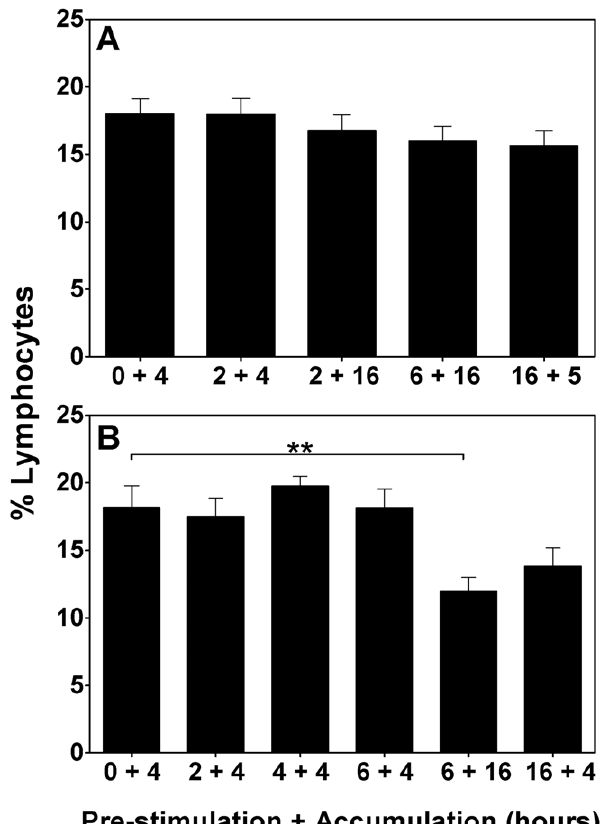
Figure 4. The effect of different culture schedules on the viability of CD4 T cells. Mouse splenocytes 6 weeks following a BCG immunization (A) and PBMC from cattle naturally infected with M. bovis (B) were isolated, stimulated with protein cocktail or PPD-B, respec- tively, stained by intracellular cytokine staining (ICS) and interrogated by flow cytometry. Graphs represent the percentage of live CD4 + lymphocytes detected in the analysis, as determined by the inclusion of a LIVE/DEAD fixable Violet dead cell stain. Data are representative of one of three independent experiments (n=6). Bars represent the mean 6 SEM; **p , 0.01;